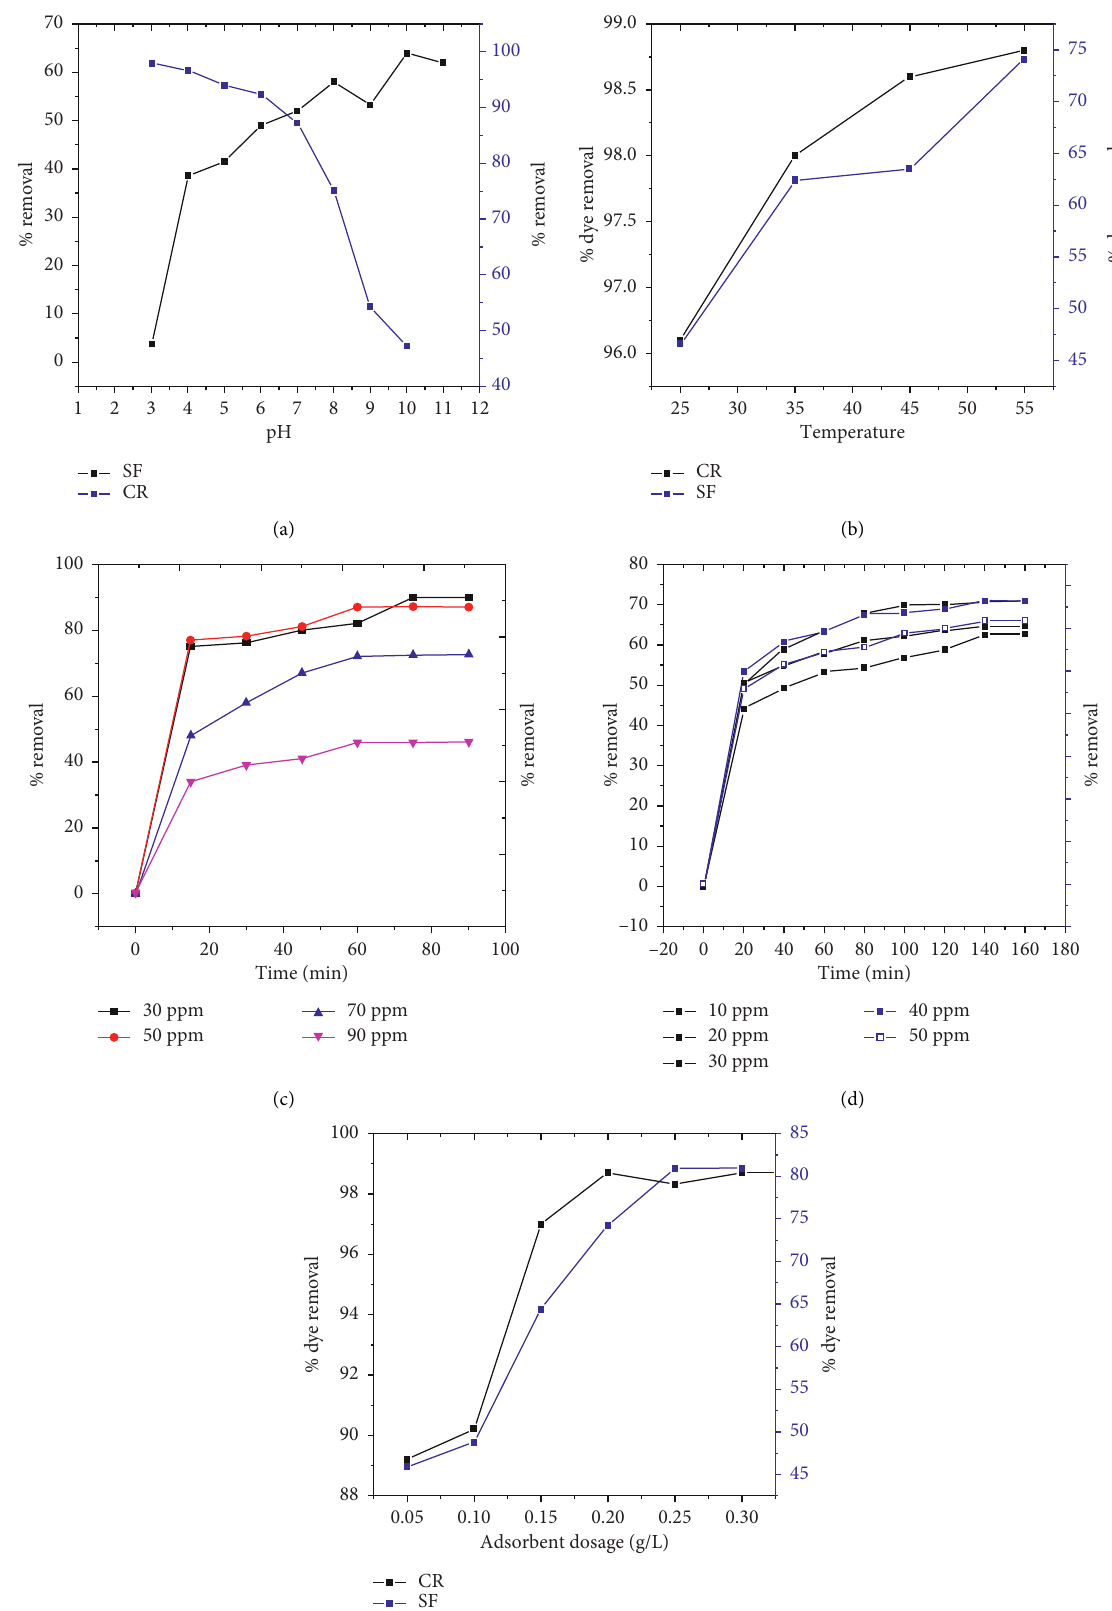
Figure 4: Effects of (a) pH; (b) temperature; (c) initial CR concentration; (d) initial SF concentration; (e) APC